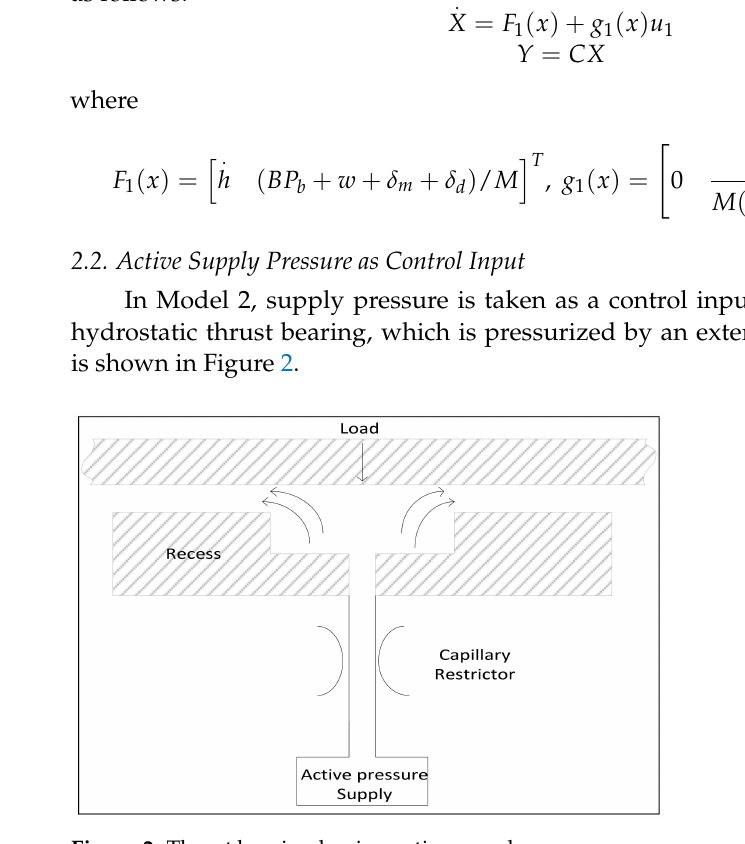
Figure 2. Thrust bearing having active supply